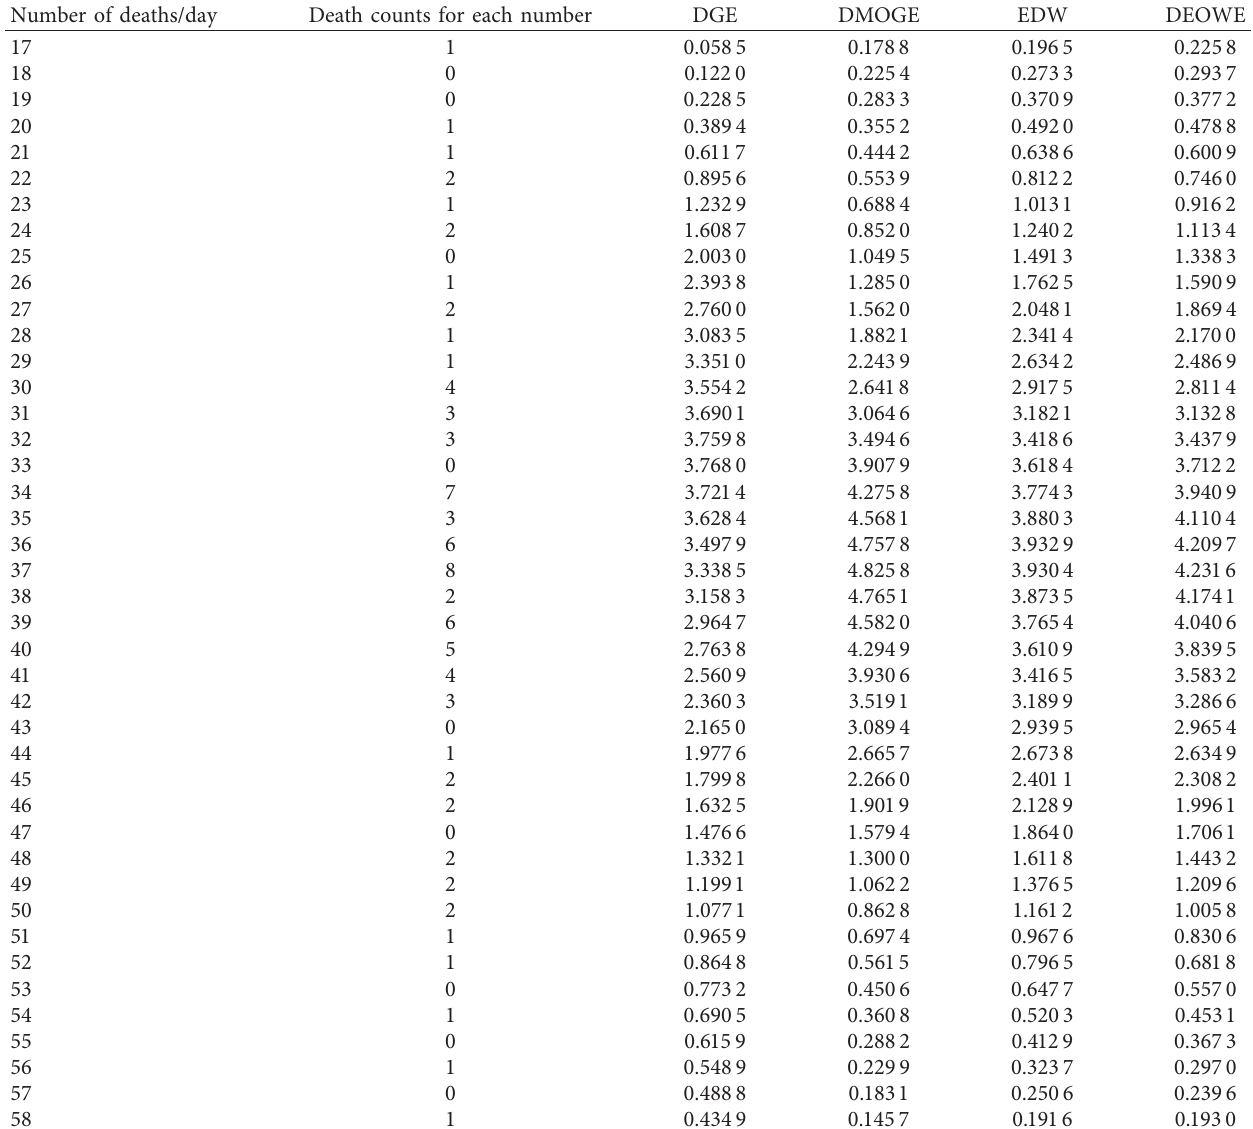
Table 8: The dataset used in this application associated with the frequency of each death number and the probability of this number. Number of deaths/day Death counts for each number DGE